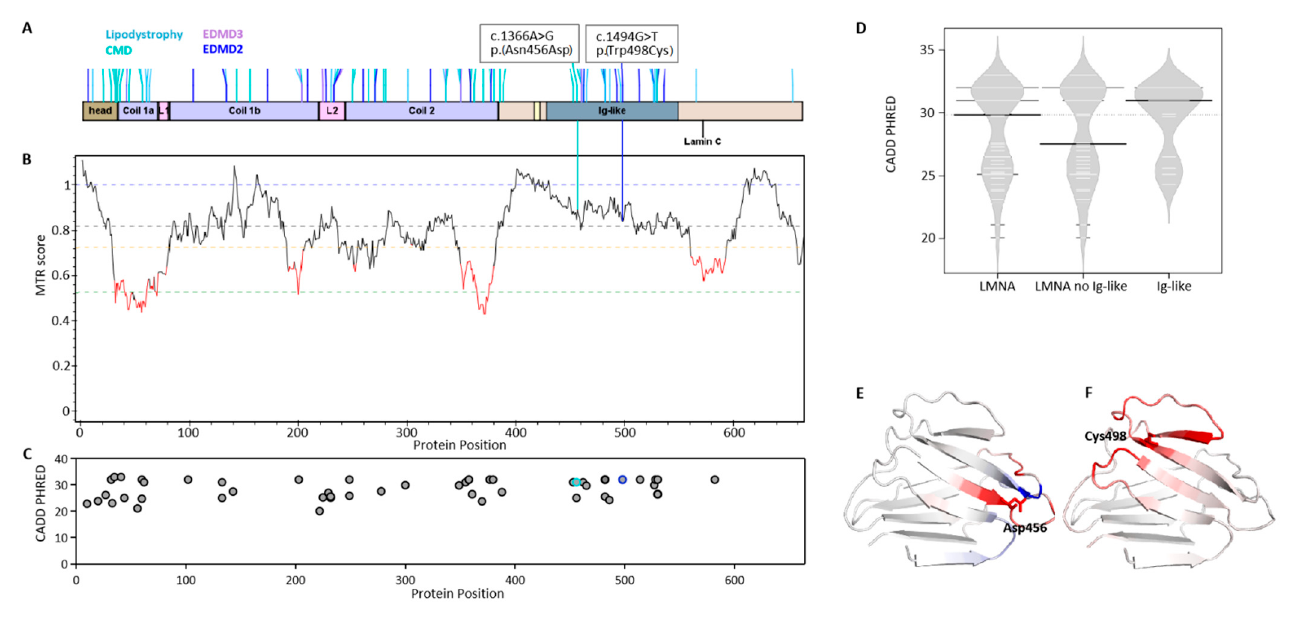
Figure 1. Mutation impact on lamin proteins in LMNA -related muscular dystrophy. ( A ) Domain organization of lamin A and lamin C with reported LMNA -related muscular dystrophy mutations. All reported LMNA variants in gnomAD database were cross-filtered for pathogenic and likely pathogenic variants with ClinVar database for the canonical transcript of LMNA (NM_170707.4) (data till August 2022). Four classes of muscular dystrophy are color-coded separately, including familial partial lipodystrophy (OMIM #15166), congenital muscular dystrophy (CMD, OMIM #613205), Emery-Dreifuss muscular dystrophy 2 autosomal dominant (EDMD2, OMIM #181350), and Emery-Dreifuss muscular dystrophy 3 autosomal recessive (EDMD3, OMIM #616516). The ClinVar and dbSNP ID for two selected variants: p.(Asn456Asp): ClinVar:66811, rs267607599; p.(Trp498Cys): ClinVar:66838, rs57730570. ( B ) Missense tolerance ratio (MTR). Horizontal lines show gene-specific MTR percentiles 5th, 25th, 50th, and neutrality (MTR = 1.0). MTR analysis took account of LMNA variants from all available exome and genome sequences for general classical laminopathy. ( C ) CADD score for selected missense mutations in LMNA − related muscular dystrophy. Highly pathogenic (score > 30) and pathogenic/probably damaging (> 20). ( D ) The CADD score summary for selected missense mutations of Figure 1C occurred across the protein ( LMNA ), no Ig − like domain regions ( LMNA without Ig − like), and Ig − like domain. ( E , F ) 3D structure with mutation generated from Dynamut. Amino acids colored according to the vibrational entropy change upon mutation. Blue represents a rigidification of the structure and red a gain in flexibility.